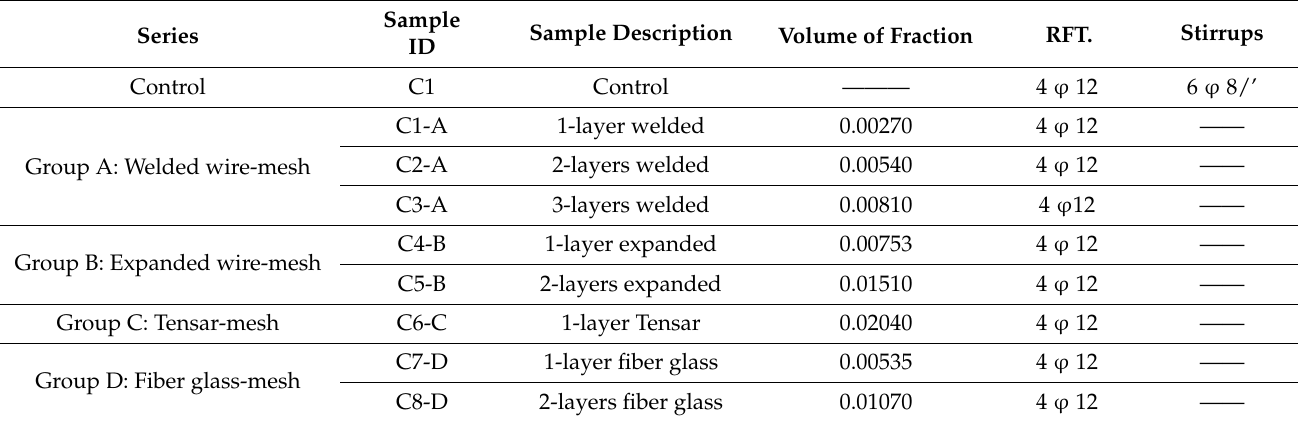
Figure 6. Concrete dimensions of columns and RFT details. Table 5. Description of the studied